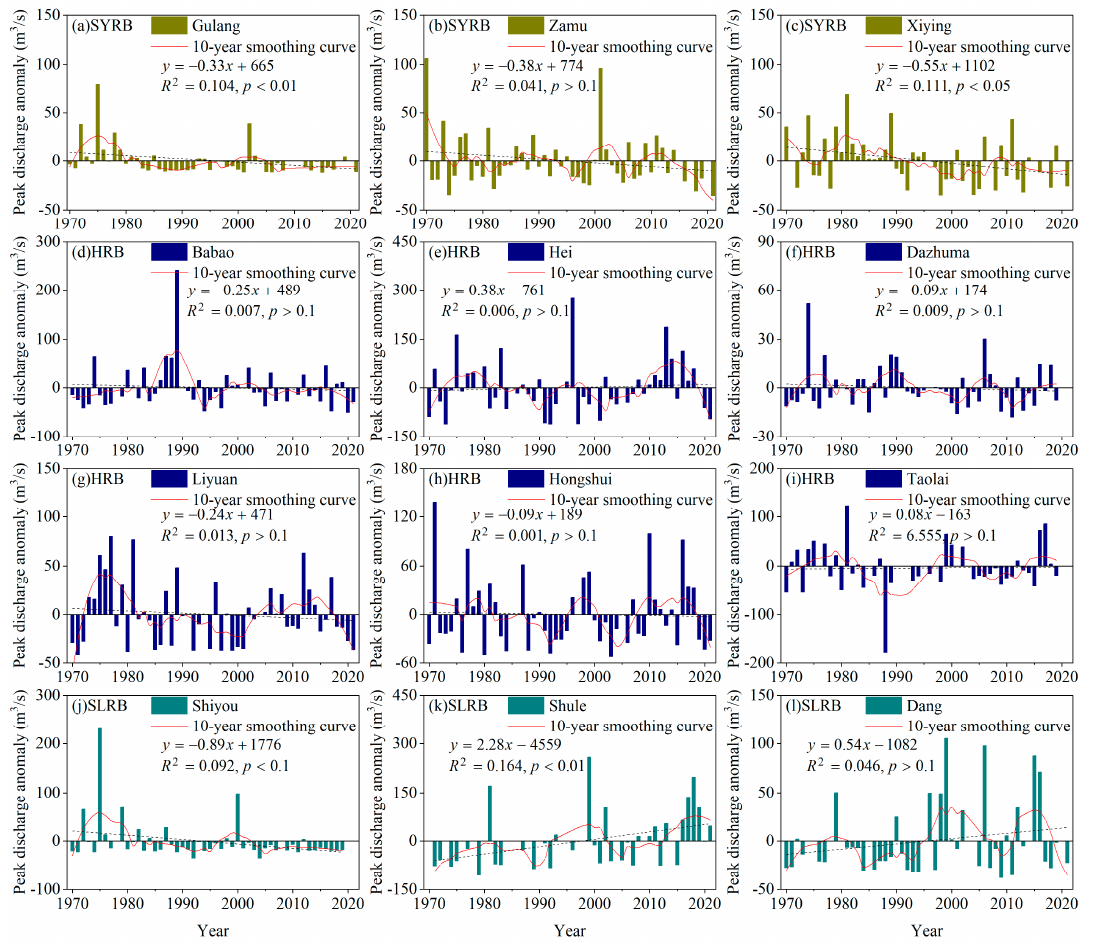
Figure 4. Trends of POT3M flood series for 12 representative rivers in the QM region, northwest China. ( a – c ) Denote Gulang, Zamu, and Xiying rivers in SYRB, ( d – i ) denote Babao, Hei, Dazhuma, Liyuan, Hongshui, and Taolai rivers in HRB, ( j – l ) denote Shiyou, Shule, and Dang rivers in SLRB, respectively.